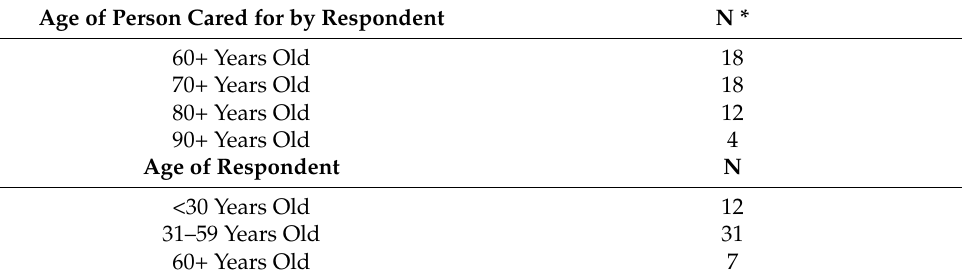
Table 2. Participant characteristics—caregivers. Age of Person Cared for by